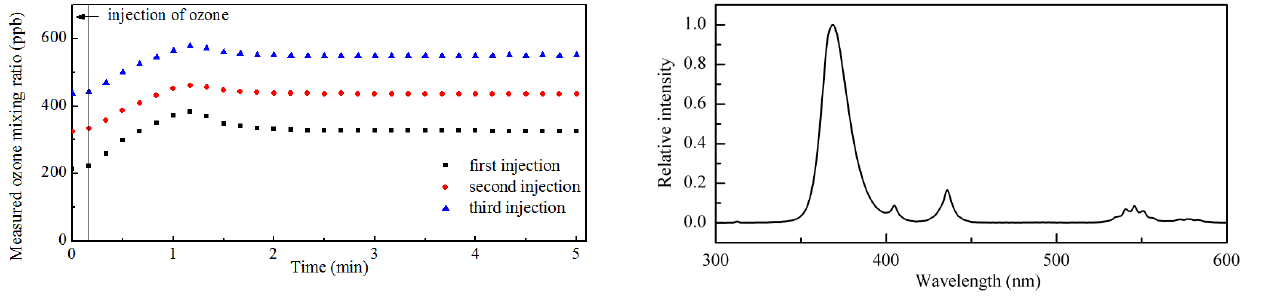
Fig. 4. Measured spectrum of black